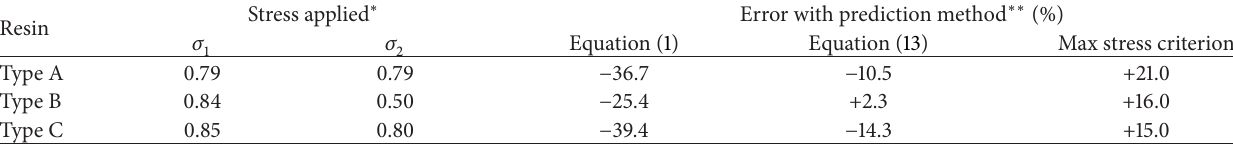
Table 3: Data from neat resin biaxial tests [8, 9] and errors with different prediction methods.